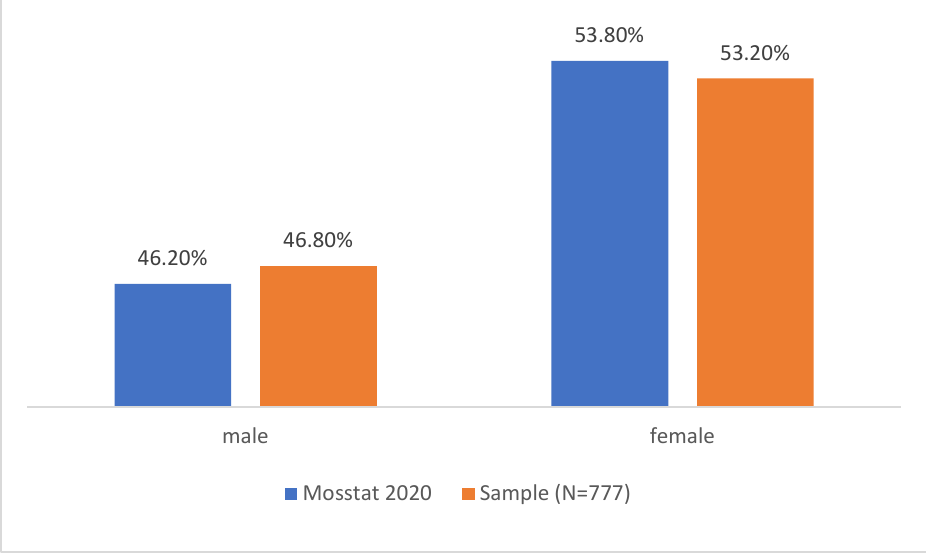
Figure 3. Comparison of gender structure between Moscow population and the sample (N = 777).